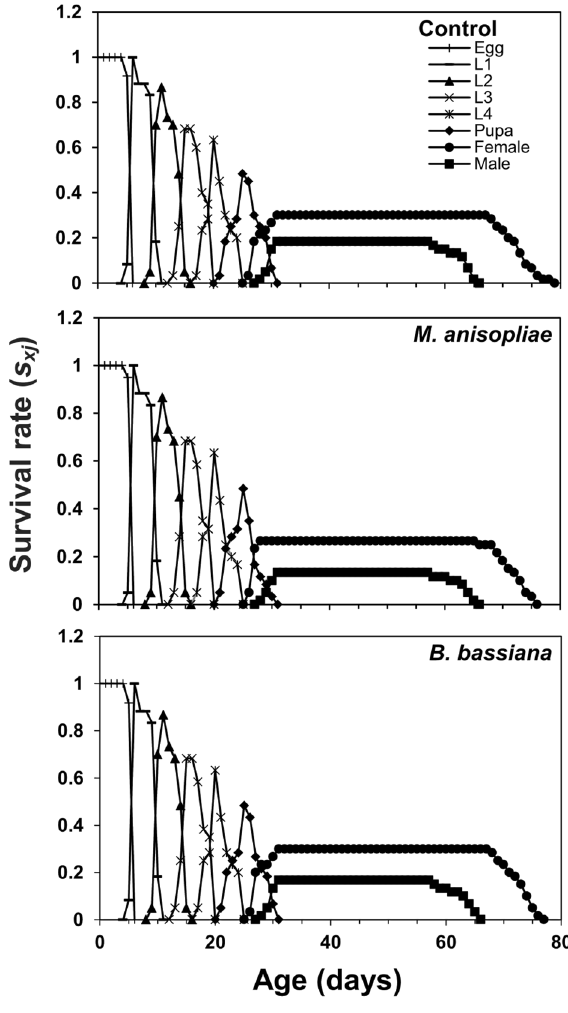
Figure 1. Age-stage–specific survival rate ( s xj ) of Coccinella septumpunctata after exposure of entomopathogenic